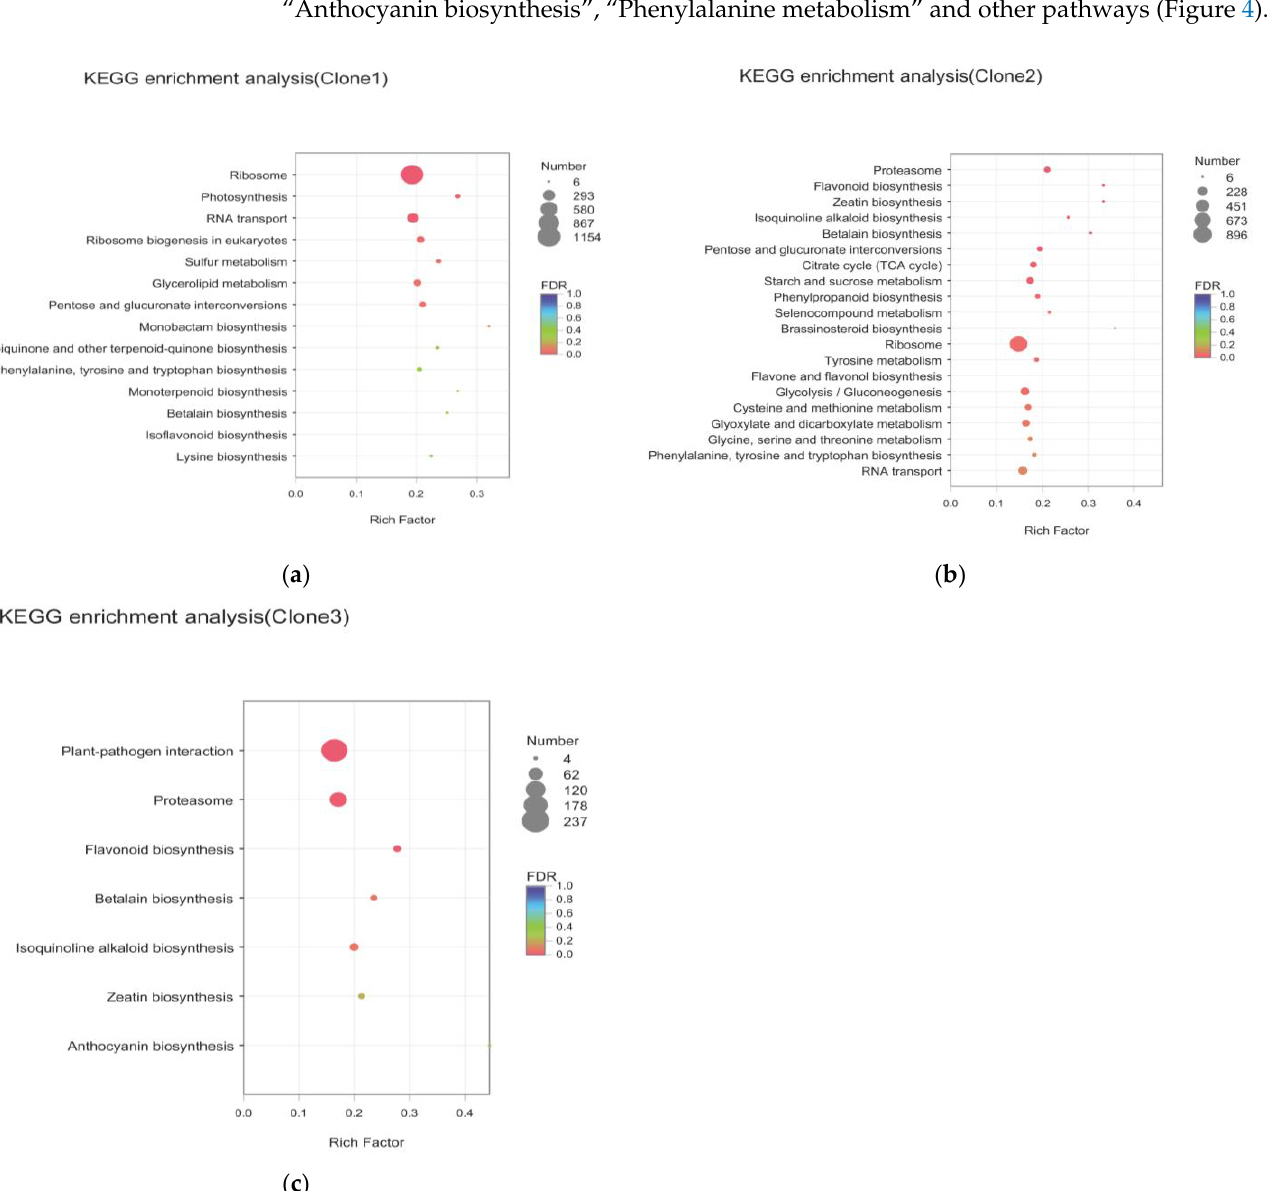
Figure 4. Enrichment of differential genes KEGG in different clones: ( a ) enrichment of differential genes KEGG in clone 1; ( b ) enrichment of differential genes KEGG in clone 2; ( c ) enrichment of differential genes KEGG in clone 3.